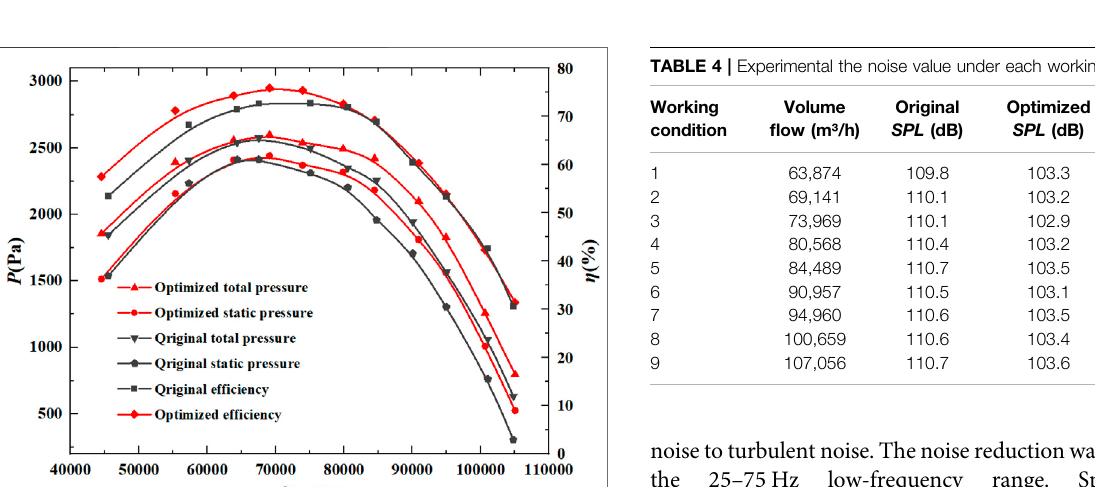
FIGURE 10 | The proo fi ng model Original and Optimized. (A) Leaf type comparison chart (B) Overall structure diagram (C) The IGVs duct position (D) Original model (E) Optimized model.